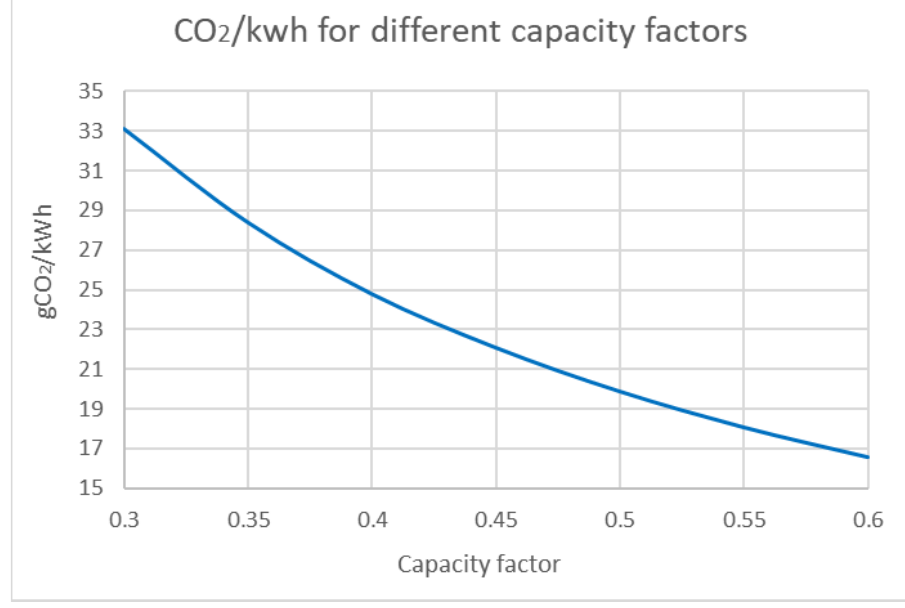
Figure 5. Changes in the CO 2 emissions for different capacity factors.